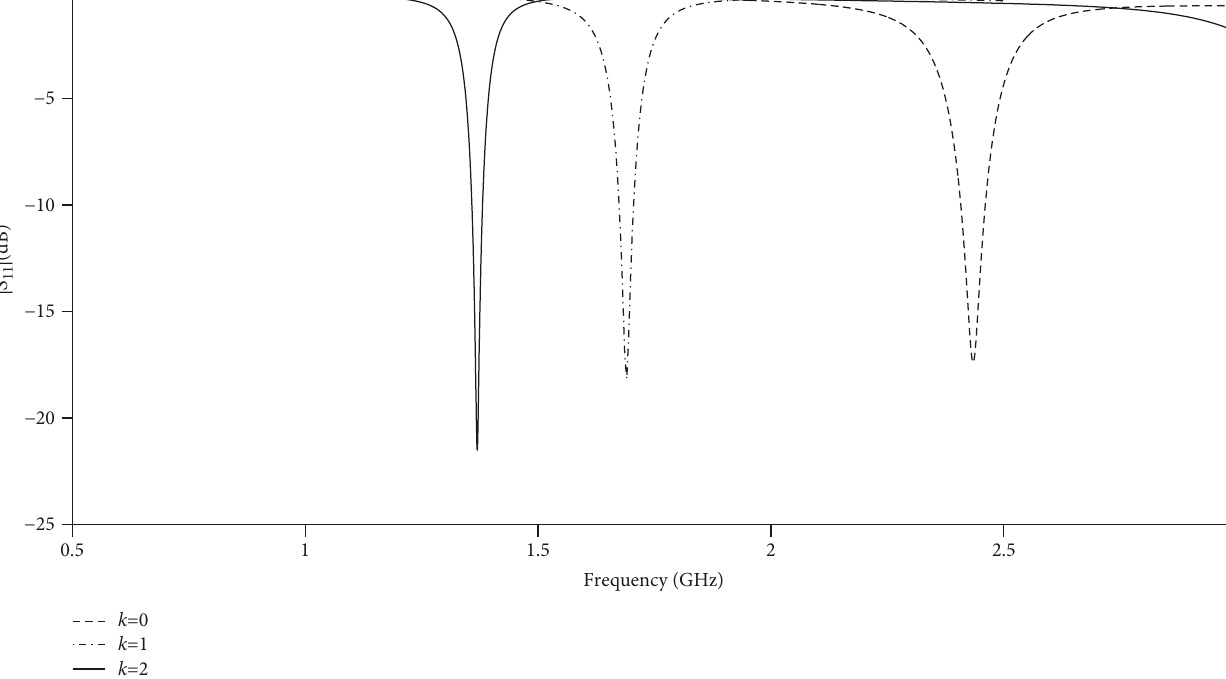
Figure 3: Simulation results for the re fl ection coe ffi cient of the Koch fractal antennas of levels k = 0 (initiator), k = 1 , and k = 2 , without the shorting